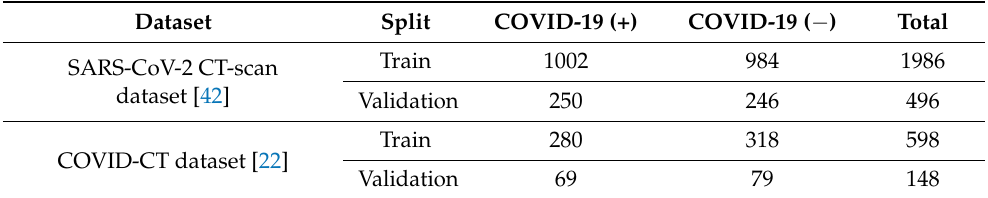
Table 2. Distribution of COVID-19 (+) and COVID-19 ( − ) CT images with respect to their collected sources.